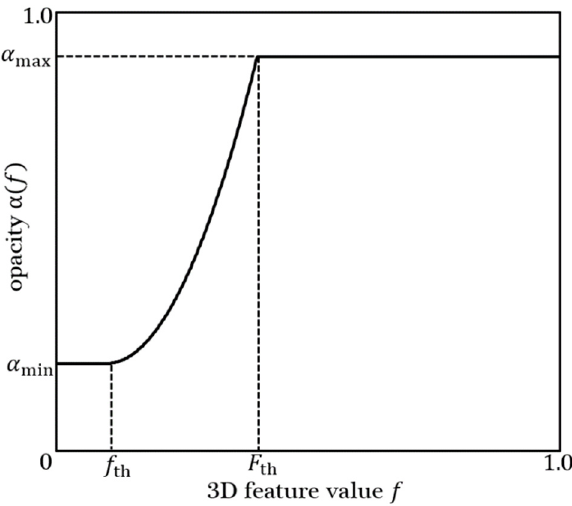
Figure 6. Typical relation between the three-dimensional feature value f and opacity α when adopting the function.